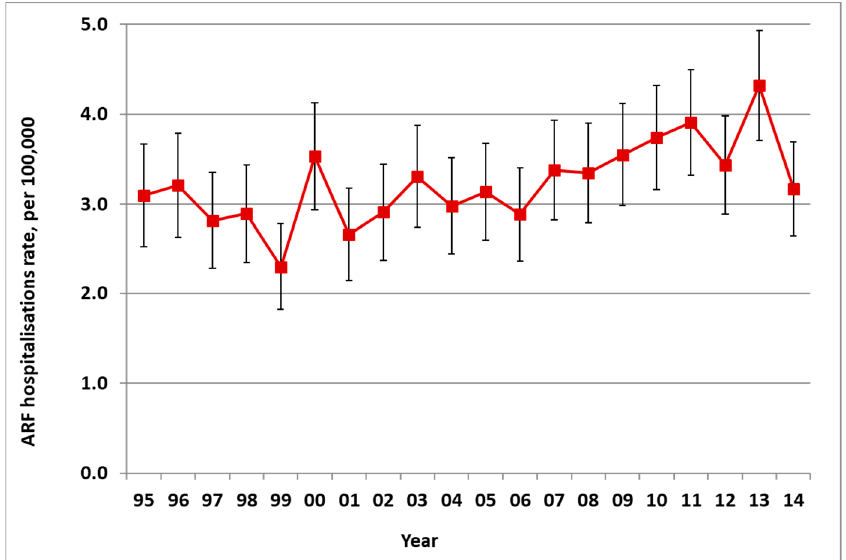
Figure 1. Acute rheumatic fever (ARF) incidence by year, initial hospitalisation rate per 100,000 with 95% CIs, 1995 to 2014.